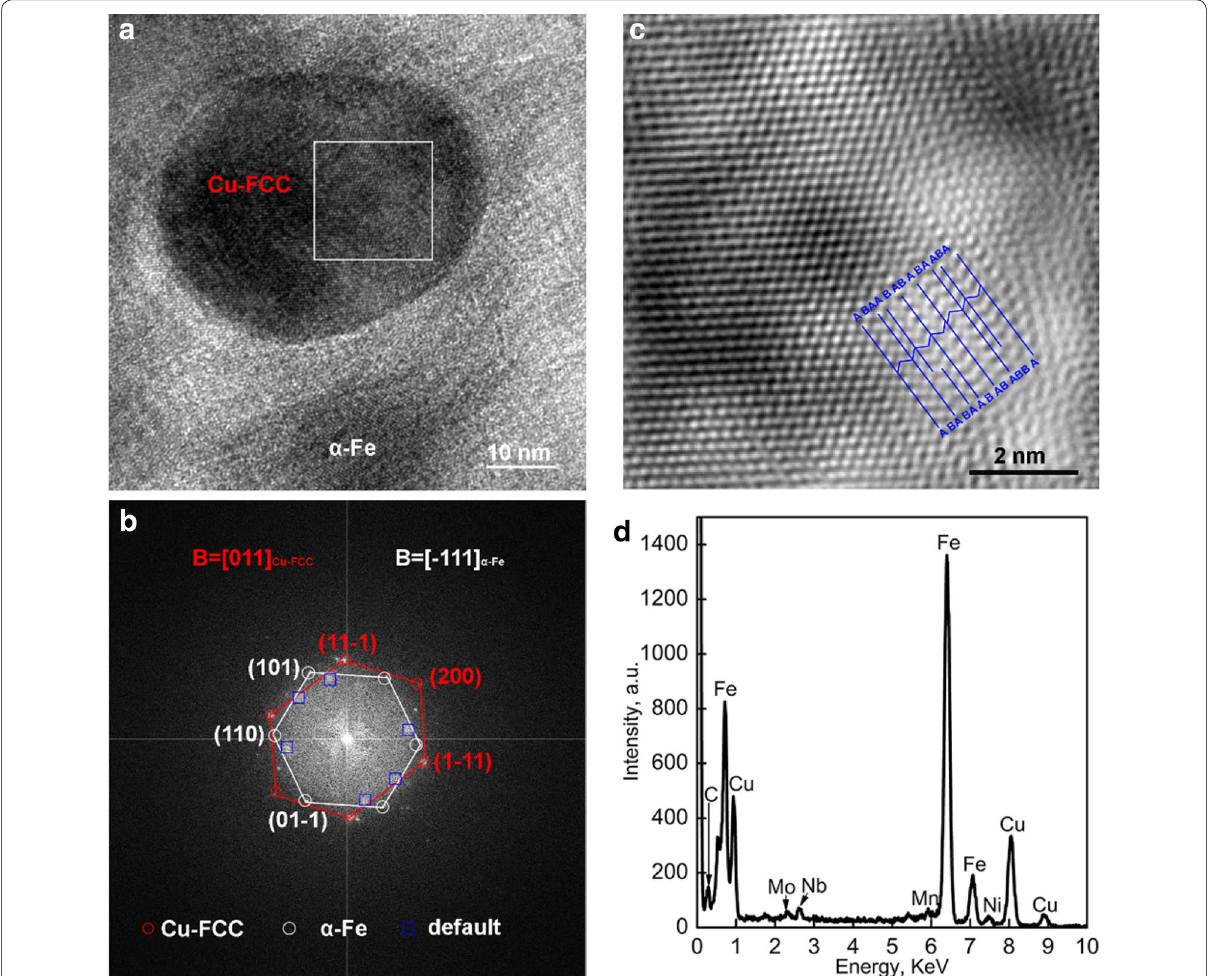
Figure 4 a HRTEM image of a coarsened FCC Cu precipitate; b FFT pattern of whole image a ; c IFFT image of the region in white square in a ; d EDS analysis of the